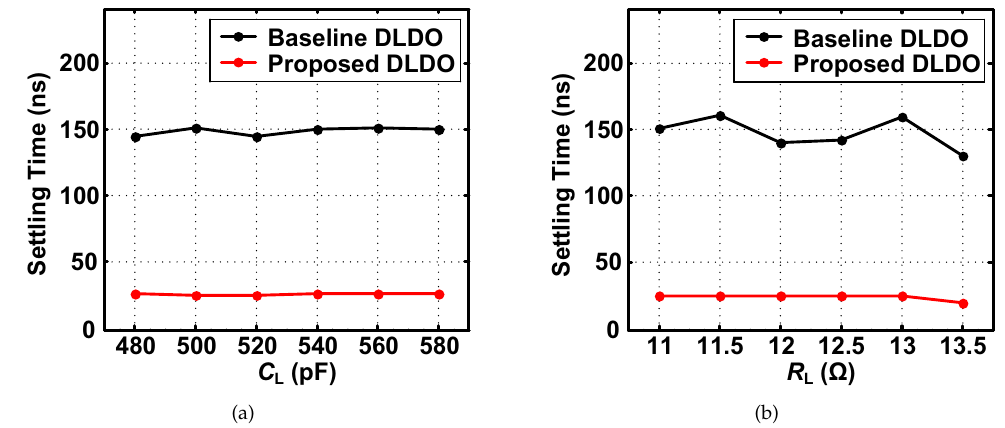
Figure 11. The settling time when: ( a ) load resistance is 11 Ω ; and ( b ) load capacitance is 500 pF.